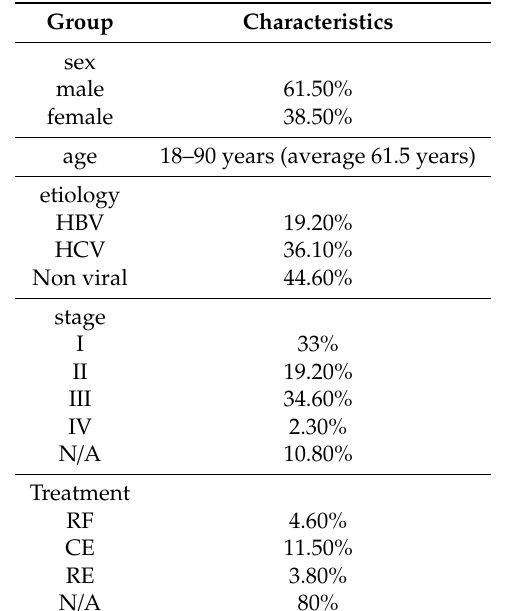
Table 1. Charateristics of Hepatocellular carcinoma (HCC) patients in The Cancer Genome Atlas (TCGA) included in the analysis of the present